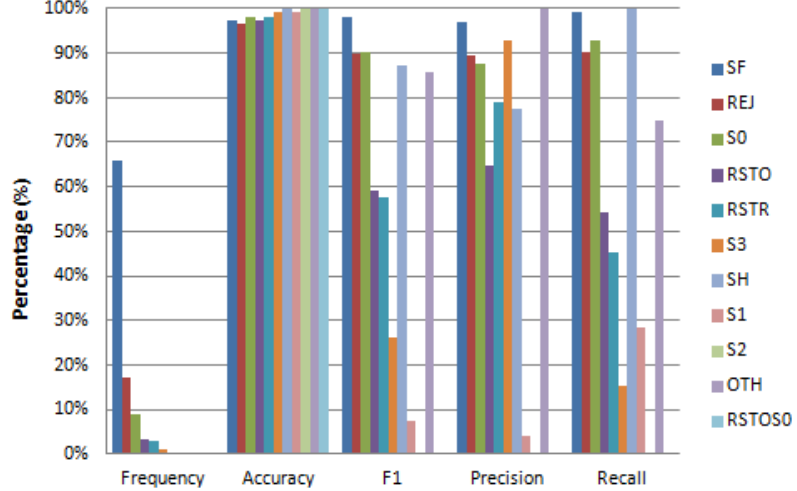
Figure 10. Performance metrics (One vs. Rest) for reconstruction of all features values when feature: ‘flag’ is missing.